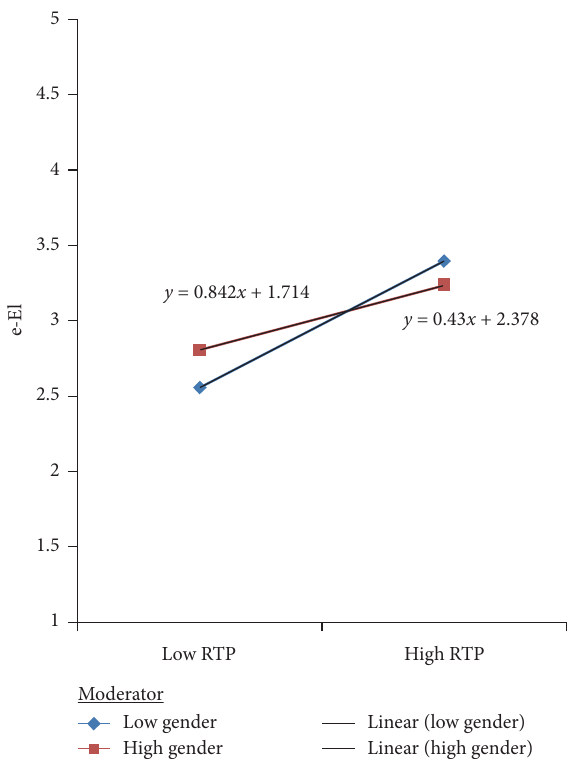
F IGURE 7: Graphical representation of interaction effect between INV and e-EI. Gender dampens the positive relationship between INV and e-EI. Source: calculated by authors based on Lowry and Gaskin